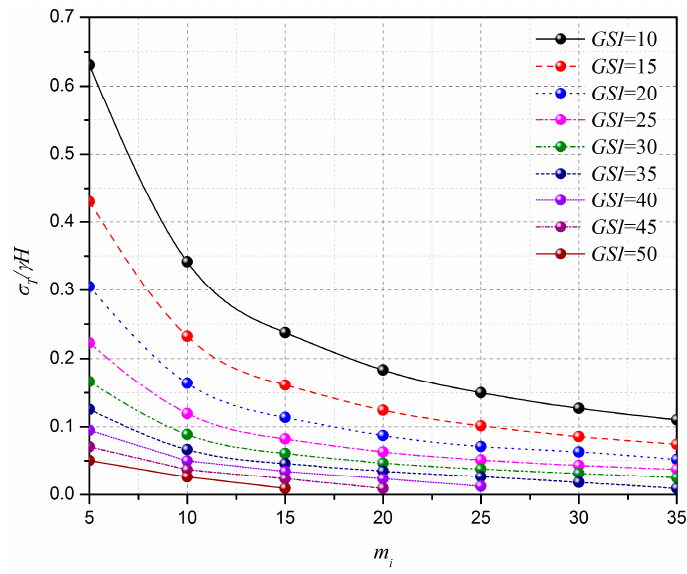
Figure 9. Effect of GSI on the 3D failure surface.